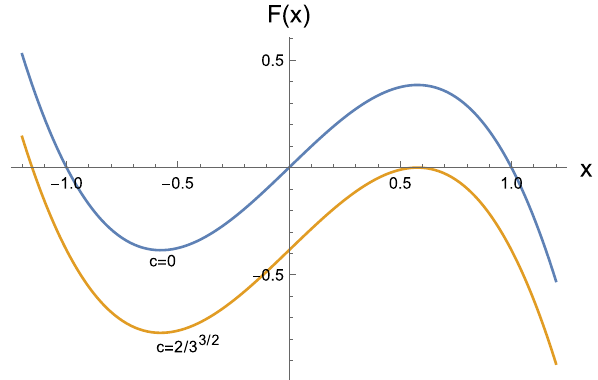
Fig. 1 Thebehaviorof F ( x ) = c − x + x 3 fortwoextremecases, c = 0 and c = 2 / 3 3 / 2 . For 0 < c < 2 / 3 3 / 2 , F ( x ) lies between two curves and both the black hole horizon and the cosmological horizon are well defined. We note that for any value of c , F ( x ) has a local maximum at √ x = 1 /